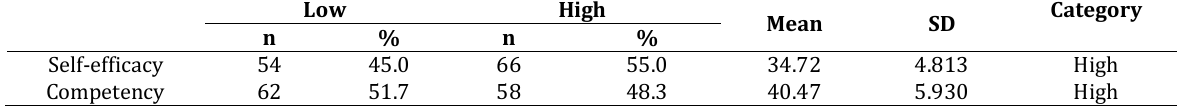
Table 4. Mean, standard deviation, frequency, and percentage level of self-efficacy and competency in implementing EBP in clinical practice (n = 120)